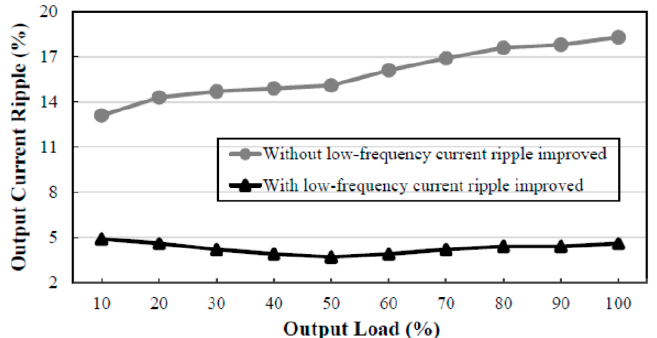
Energies 2020 , 13 , x FOR PEER REVIEW 16 of 18 Figure 17. Curve of output current ripple versus output load under 110 V input voltage.